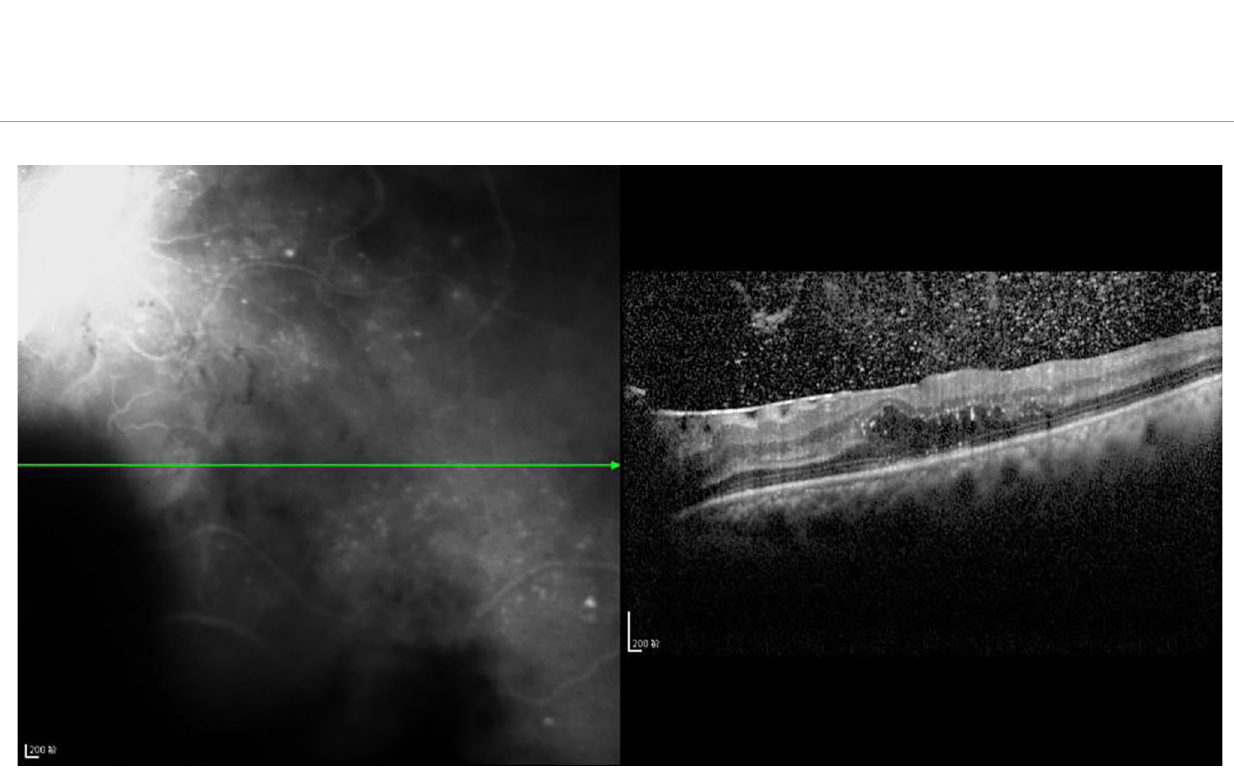
FIGURE 8 | The CFT value is 536 m m, the fracture distance of the ELM layer is 1,189 m m, the fracture distance of the IS/OS layer is >2,000 m m, and there is outer retinal